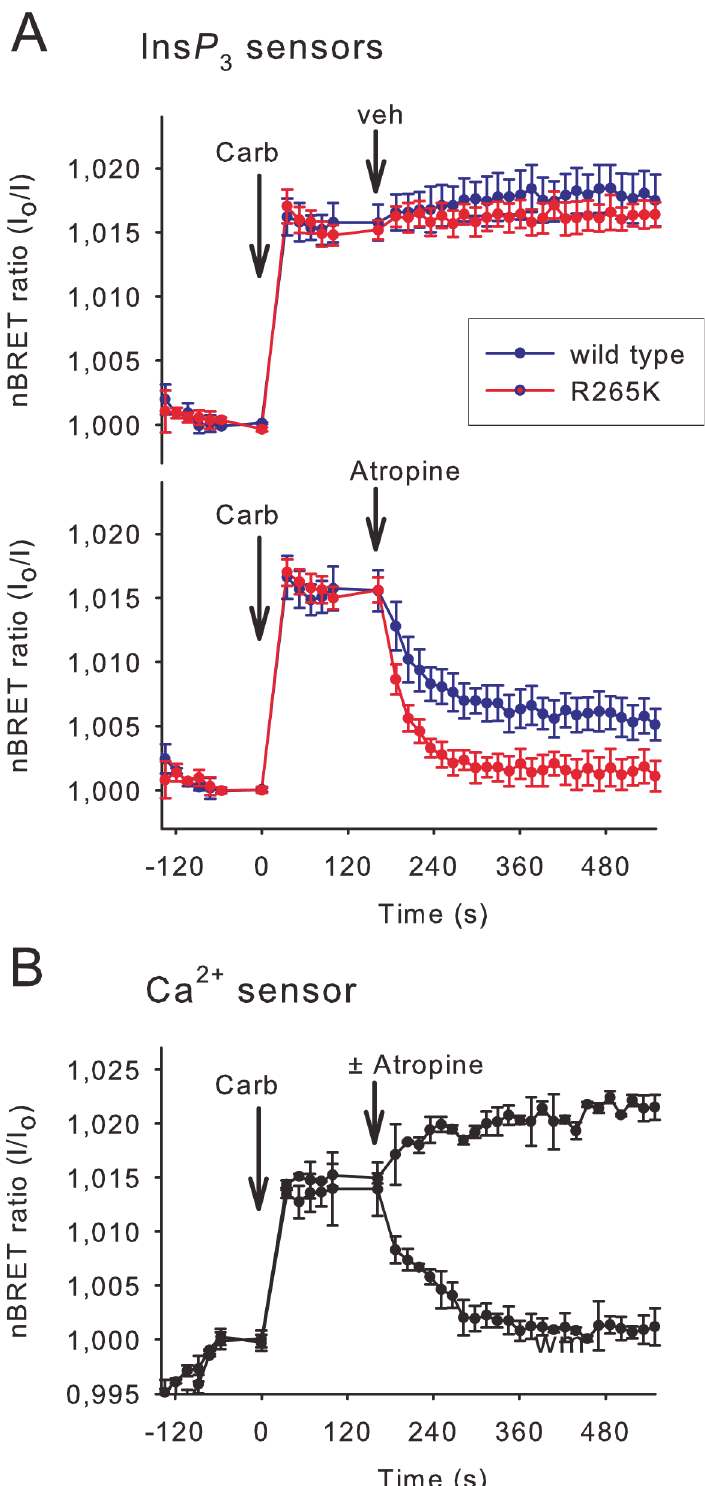
Fig 3. Comparison of the reversibility of the wild type and low-affinity Ins P 3 sensors. (A) Ins P 3 production was evoked in HEK 293T cells expressing the M3 cholinergic receptor and various BRET Ins P